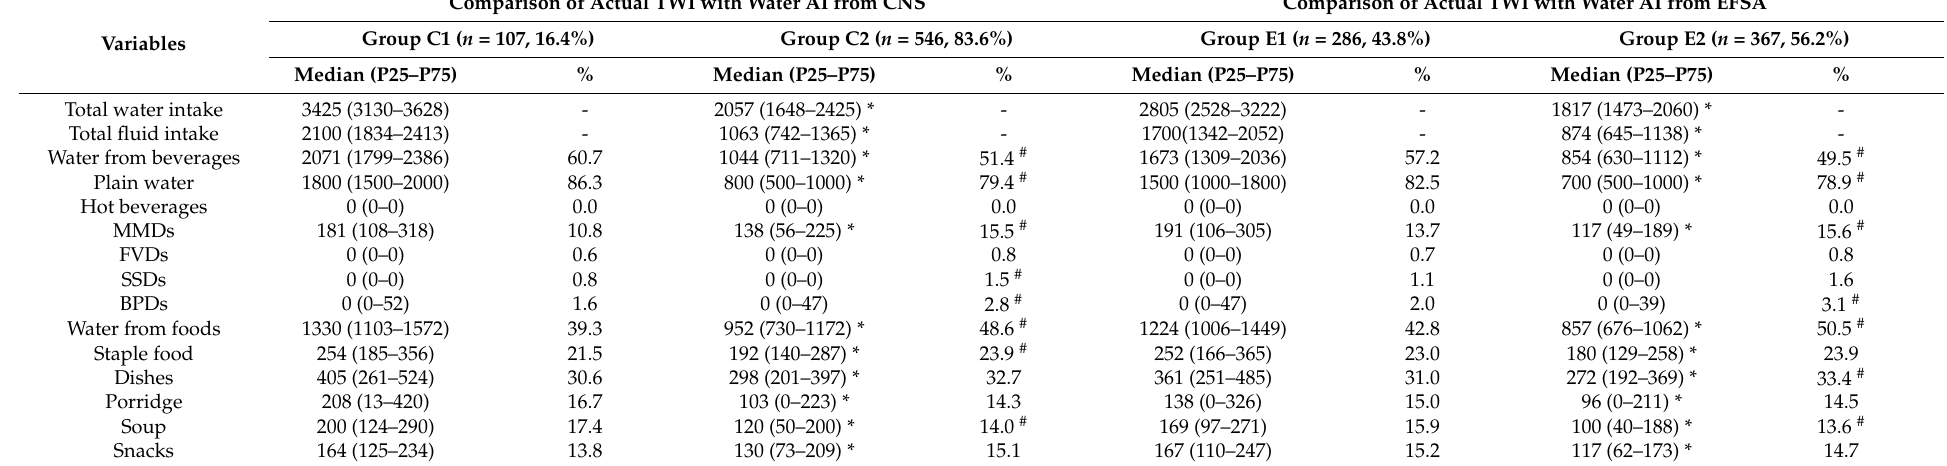
Table 2. Median daily water intake (mL/day) and contribution of water intake from different sources (%) among Chinese pregnant women in 2018 categorized by adequate intakes of total water intake set by the Chinese Nutrition society or European Food Safety